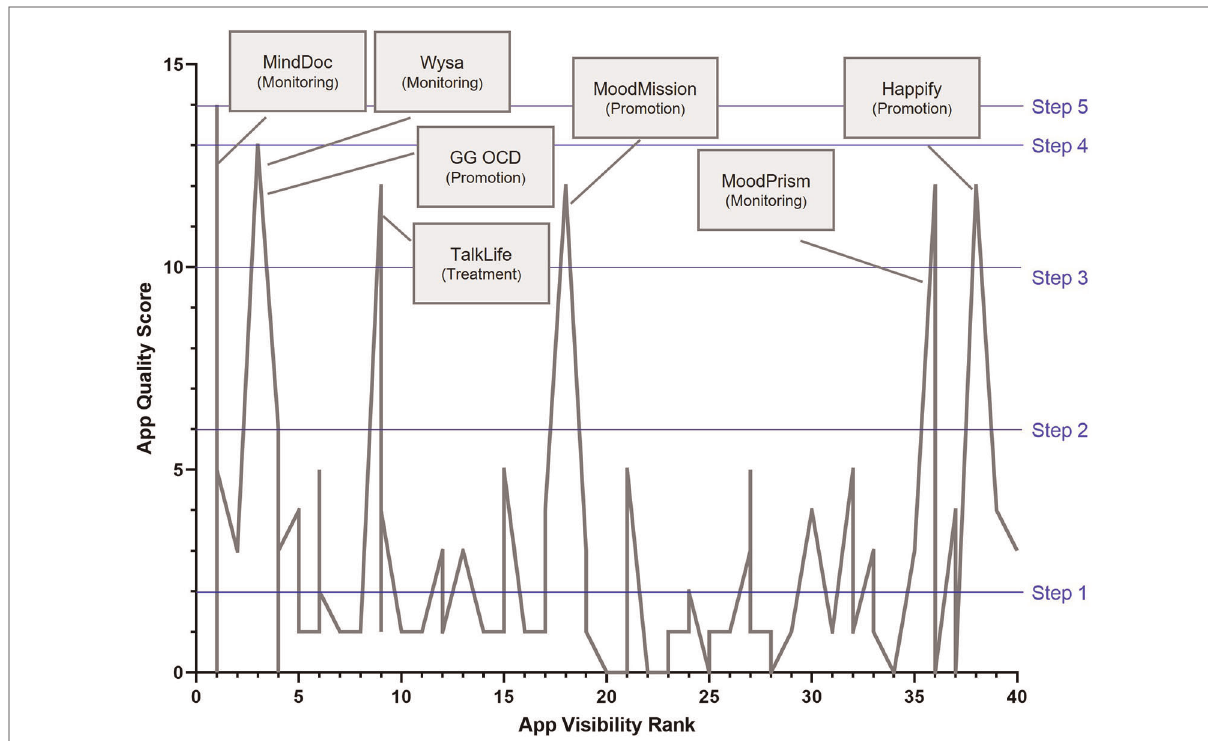
FIGURE 6 Association between apps visibility ranking (x-Axis, with rank of 1 being the most visible app on app stores) and app ’ s quality score (out of maximum 14). Assessment criterion steps marked in blue lines, and highest quality apps fl agged with callout descriptions. Note. That several apps can be ranked equally (as a result of multiple search terms and two app stores used), so each rank can demonstrate a range of quality